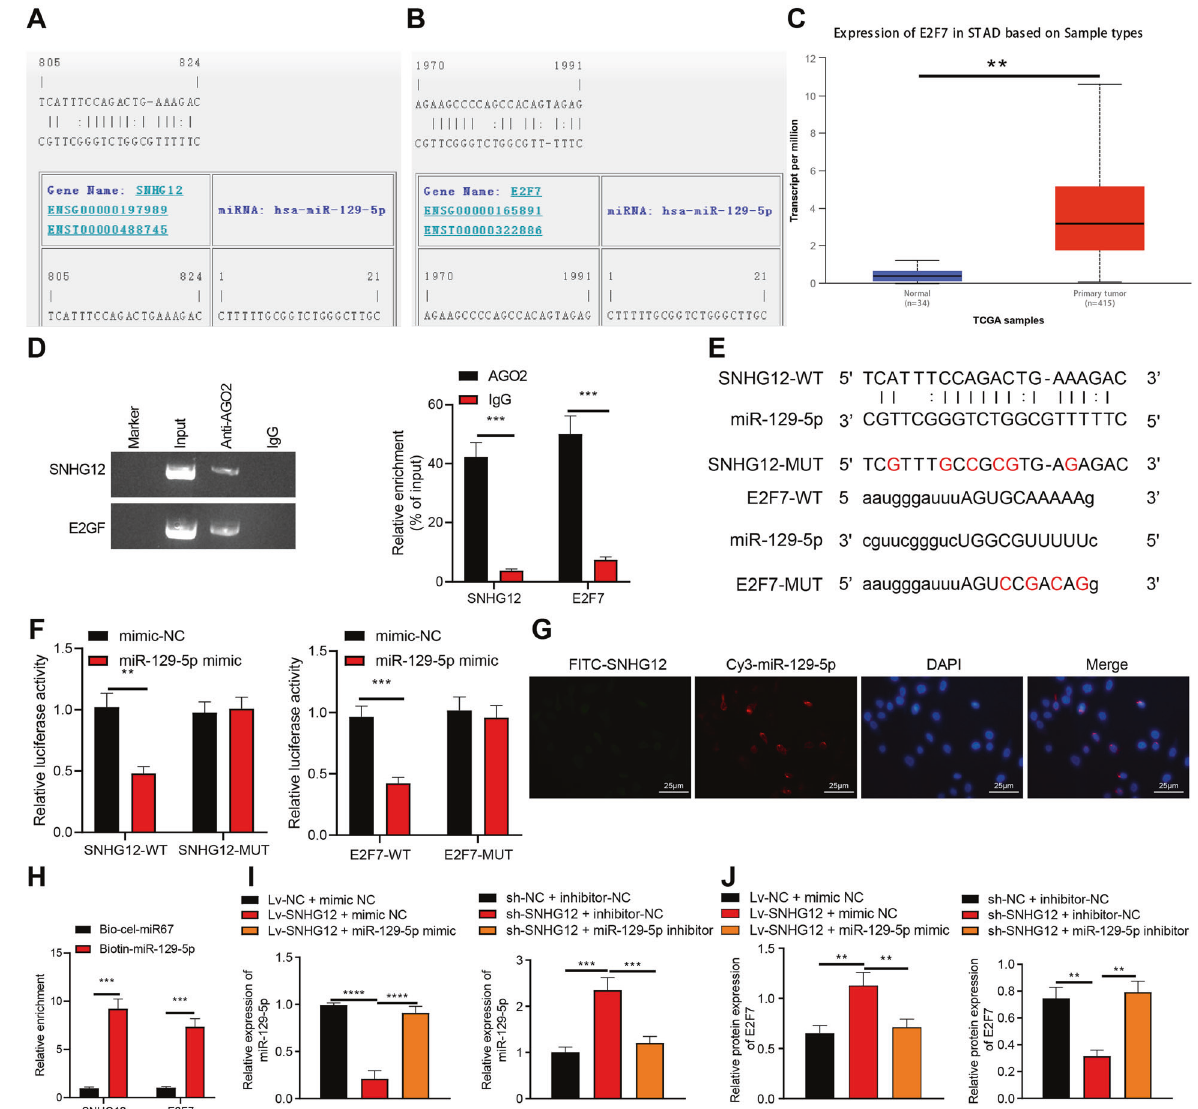
Fig. 1 SNHG12 regulates the expression pattern of E2F7 through miRNA-dependent mechanism. A The target binding sites of SNHG12 and miR-129-5p predicted by the RNA22 website. B The target binding sites of E2F7 and miR-129-5p predicted by the starbase website. C The expression box plot of E2F7 in STAD, the gray box represents the expression in normal samples, and the red box the expression in GC samples. D Interaction between SNHG12 and E2F7 in HPMCs detected using RIP assay. E WT and MUT binding sites between SNHG12 and miR-129-5p as well as between miR-129-5p and E2F7. F Luciferase activity analyzed using dual-luciferase reporter gene assay after HEK-293T cells were co- transfected with WT or MUT of SNHG12 or E2F7, miR-129-5p mimic or NC. G The co-localization of Cy3-miR-129-5p (red) and FITC-SNHG12 (green) in HPMCs cells measured using FISH (scale bar = 25 μ m), and the nucleus was stained with DAPI (blue). H Direct binding between SNHG12 or E2F7 and miR-129-5p in HPMCs detected by RNA pull-down assay. I miR-129-5p expression pattern in HPMCs evaluated by RT- qPCR. J E2F7 protein expression pattern in HPMCs measured by western blot analysis. p < 0.05, ** p < 0.01, *** p < 0.001, **** p < 0.0001. The experiment was conducted three times